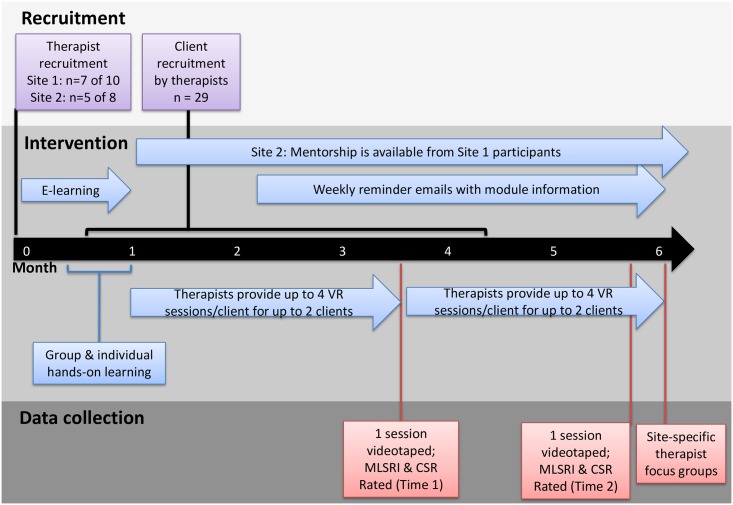
Study procedures.